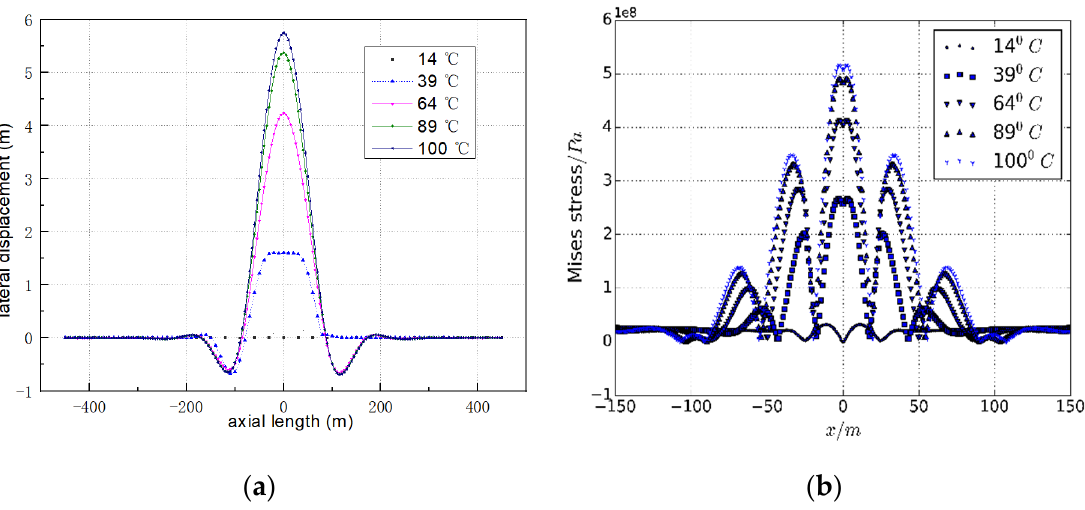
Figure 4. Result of a PIP system on global buckling. ( a ) Displacement development; ( b ) stress development.